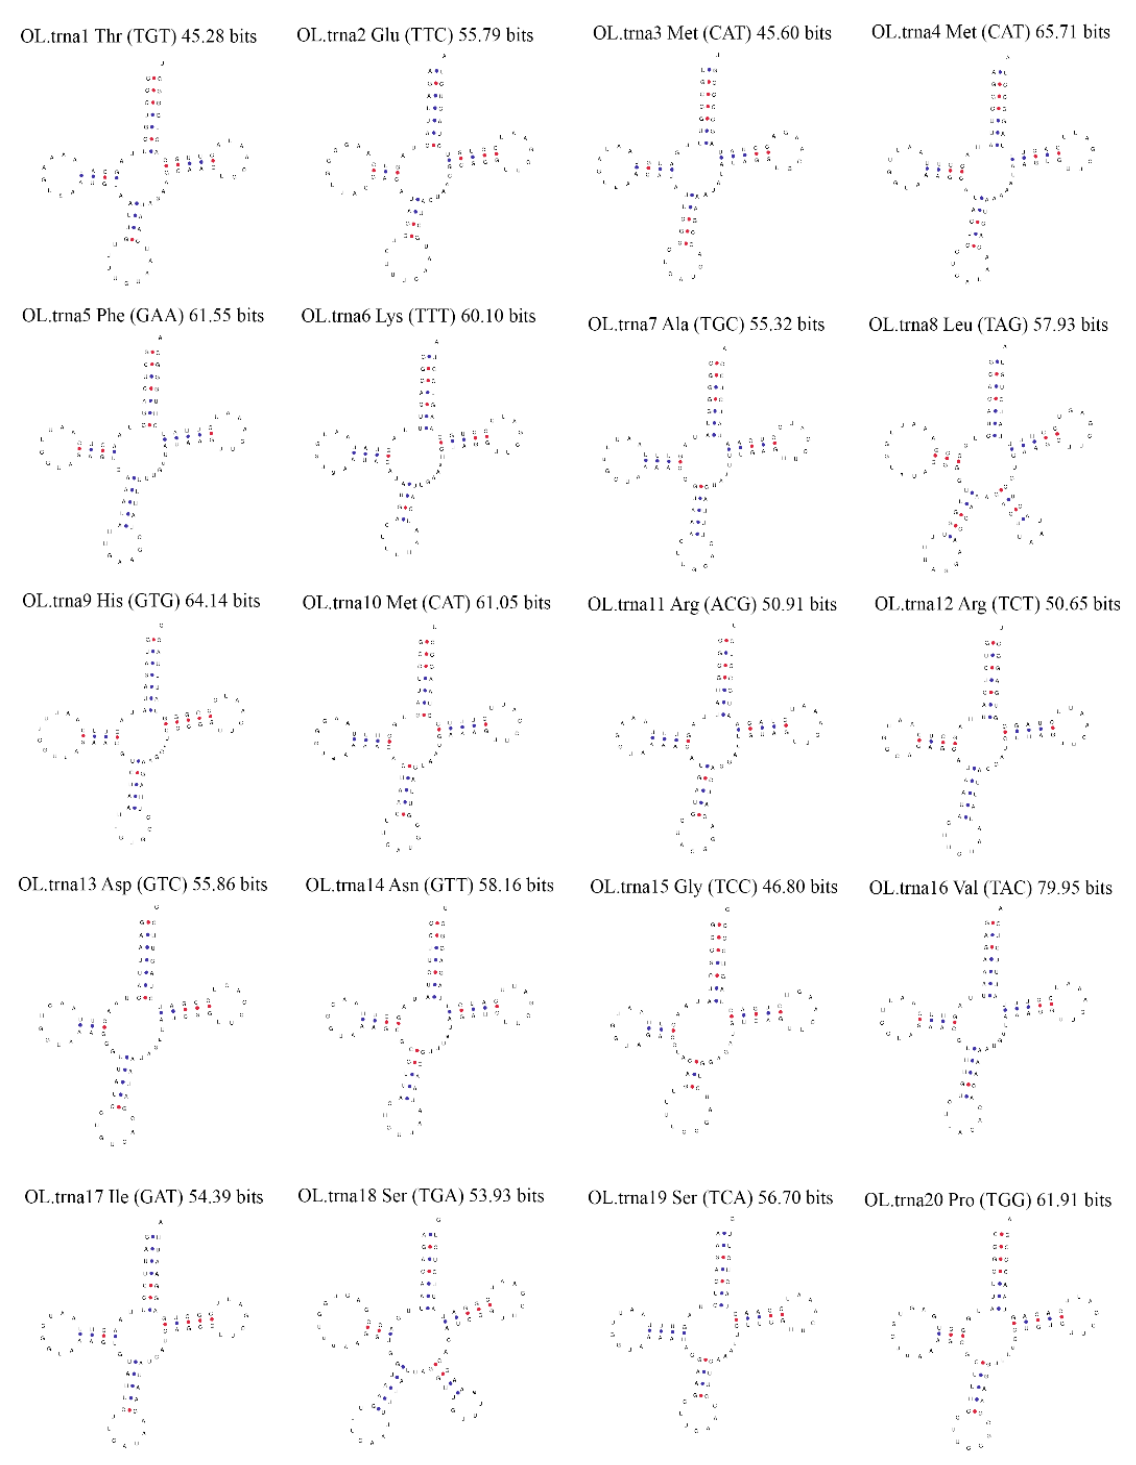
Figure 4. Cloverleaf representation of predicted secondary structures of tRNA genes from the O. lanpingensis mitogenome. Each tRNA is labeled with the abbreviation of its corresponding amino acid. The tRNA structural plots were generated using MITOS software (http://mitos.bioinf.uni-